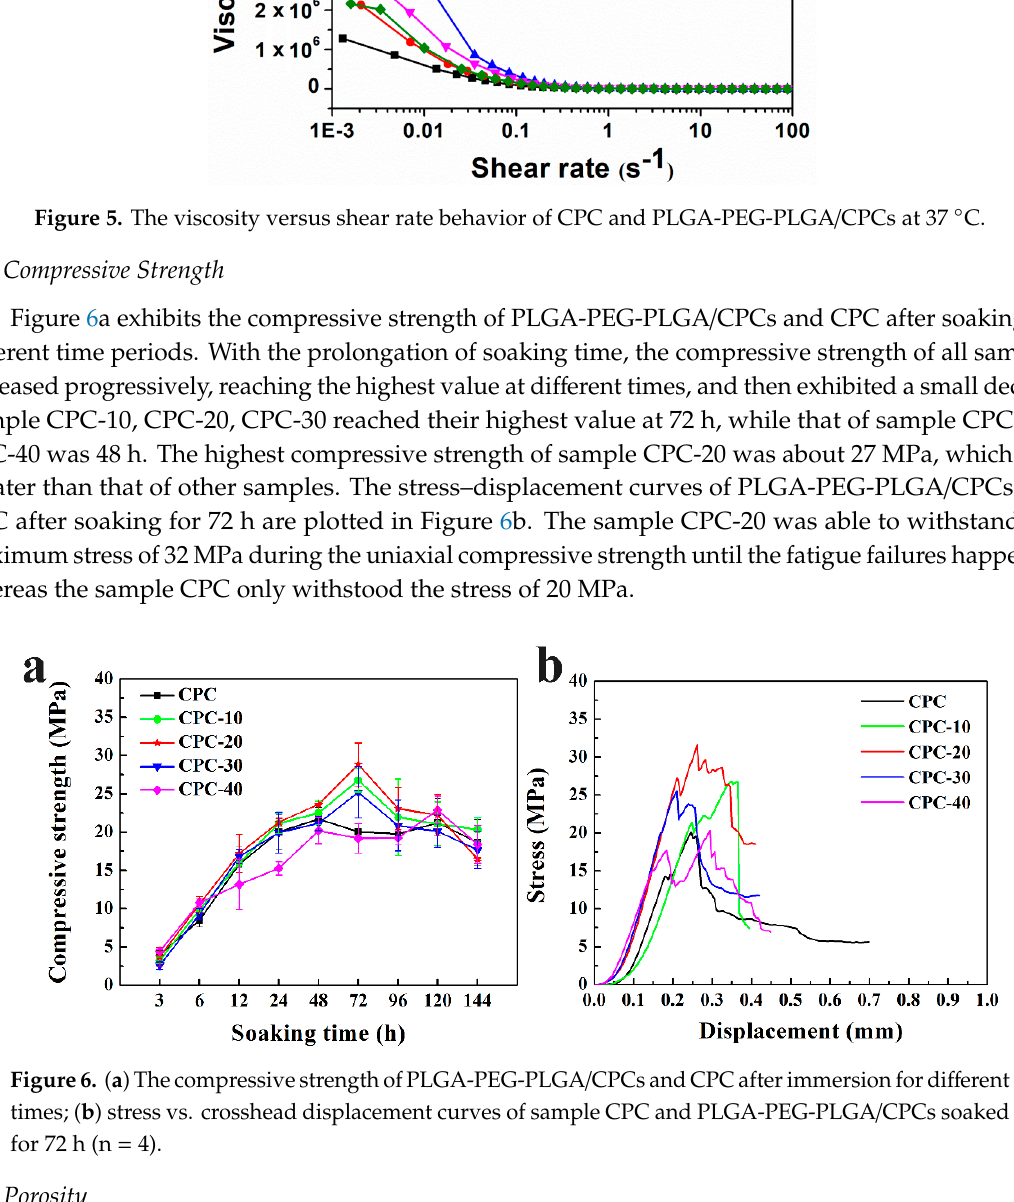
Figure 7. The porosity of CPC and PLGA-PEG-PLGA/CPCs after immersion for three days (n = 5, ** p < 0.001, * p < 0.05). 3.7. In vitro Degradation 3.7.1. Weight Loss It can be seen from the above results that sample CPC-10 and CPC-40 could not meet operation requirements due to the poor injectability and compressive strength, so only sample CPC-20 and CPC-30 were selected in the following study. The weight loss of PLGA-PEG-PLGA/CPCs and CPC after immersion in SBF solution for certain intervals is shown in Figure 8. Before 144 h, the weight loss of composite CPCs and CPC changed apparently, meanwhile the composite CPCs had lower weight loss than CPC. After seven days, the weight loss of CPC slowed down, whereas the weight loss of composite cements began to increase and the weight loss of sample CPC-20 kept up with that of CPC after 21 days.